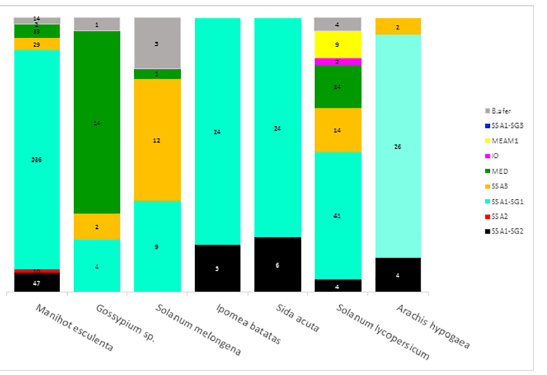
Fig 5. Distribution of 898 individuals of B . tabaci putative species and genetic groups on sampled host plants at sites in Central African Republic.